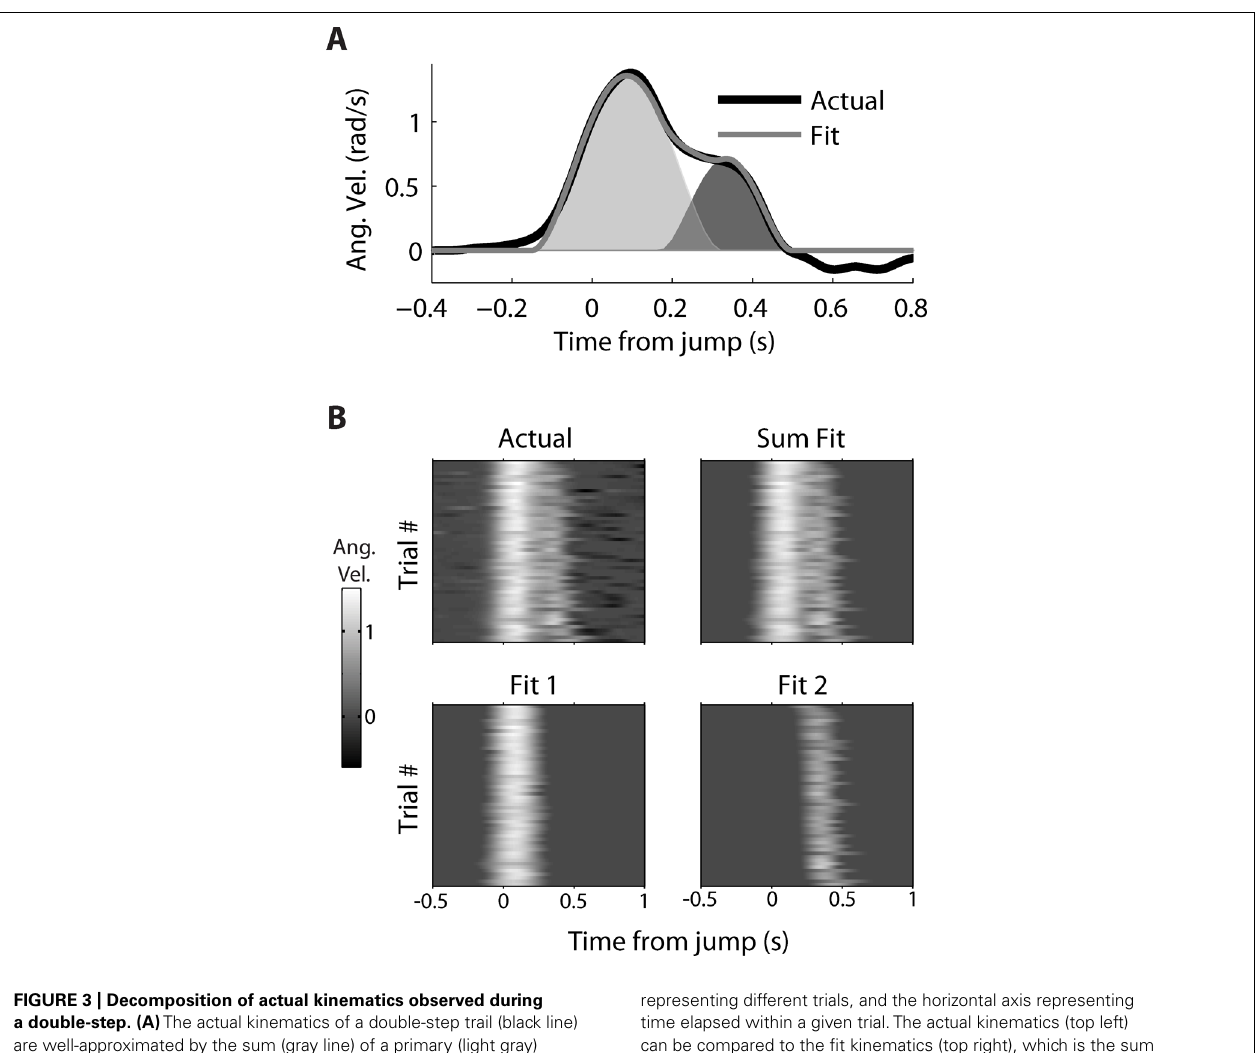
FIGURE 3 | Decomposition of actual kinematics observed during a double-step. (A) The actual kinematics of a double-step trail (black line) are well-approximated by the sum (gray line) of a primary (light gray) and secondary (dark gray) single-peaked profiles. (B) The single-trial velocity profiles are displayed as heat maps, with the vertical axis